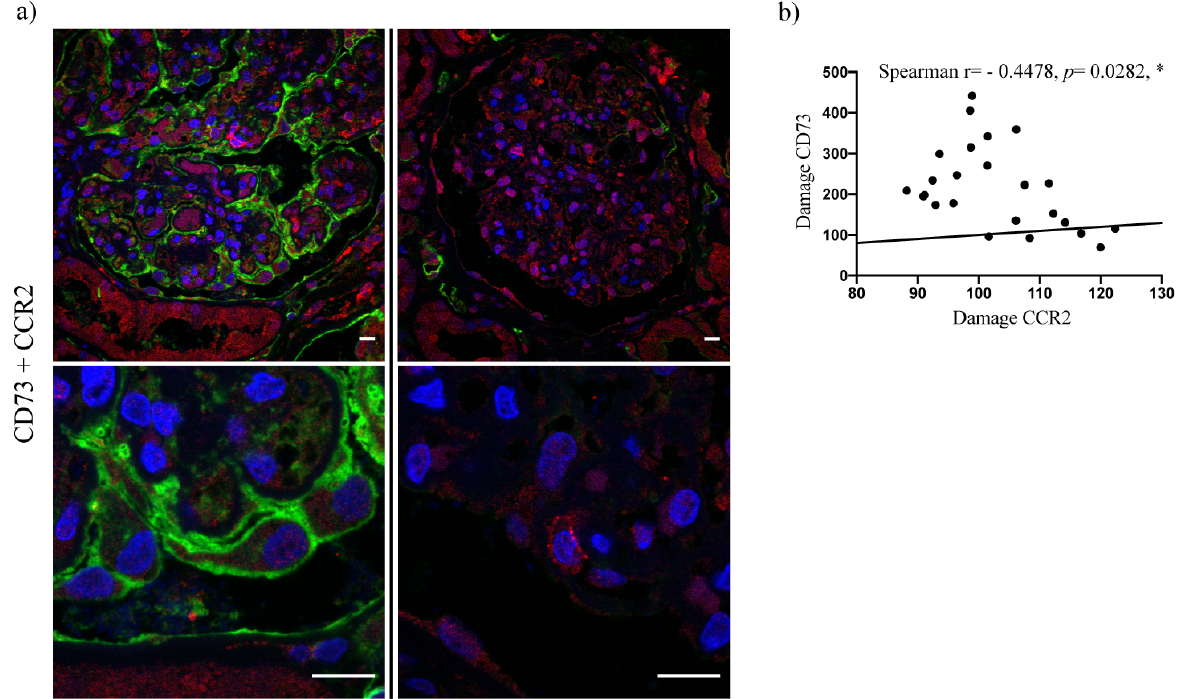
Figure 5. Inverse CD73/CCR2 correlation in podocytes by immunofluorescence. ( a ) CD73 (green signal) and CCR2 (red signal) co-staining in biopsy samples of two patients (left and right column). Images were acquired using the 60×/1.35 UPlanSApo objective. Bars = 10 µm. ( b ) Scatter plot with bars showing negative correlation between CD73 and CCR2 mean fluorescence intensity in podocytes (data are presented as mean SEM). The correlation was assessed by Spear- man ’ s non-parametric test ( Spearman r = −0.4478; p = 0.0282, * significant negative correlation).